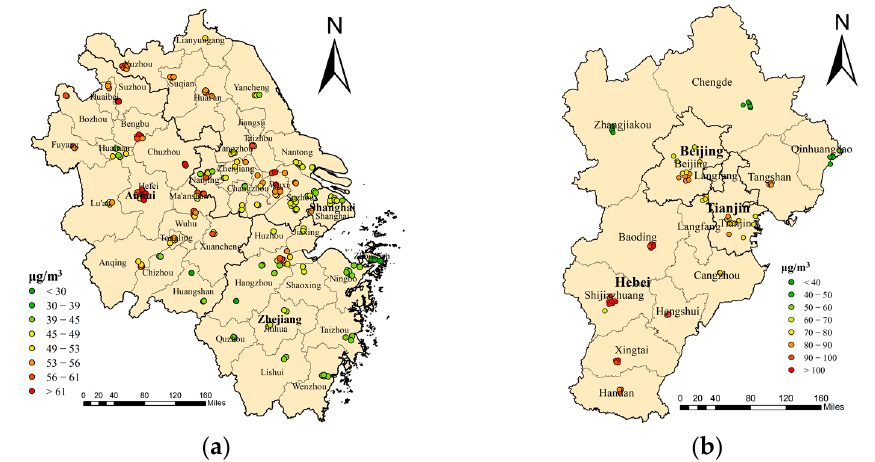
Figure 3. Distribution map of the annual average PM 2.5 observations: ( a ) the YRD region; ( b ) the BTH region.